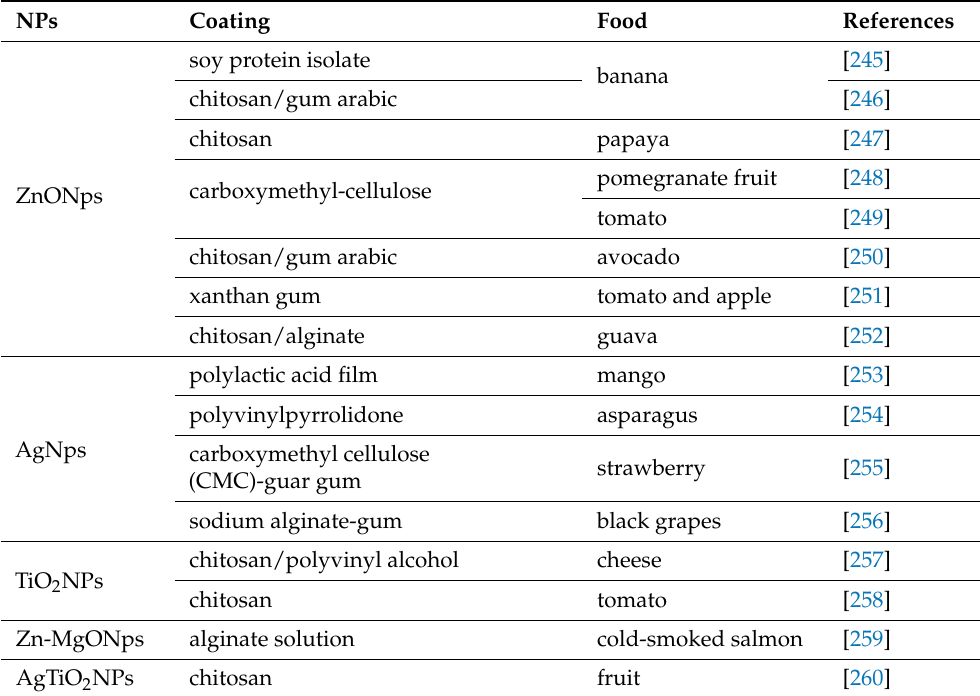
Table 4. Examples of the use of metal nanoparticles in edible